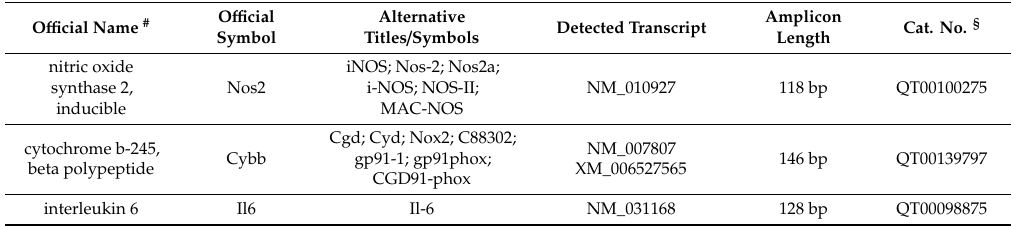
Table 2. The list of primers used for quantitative real-time PCR